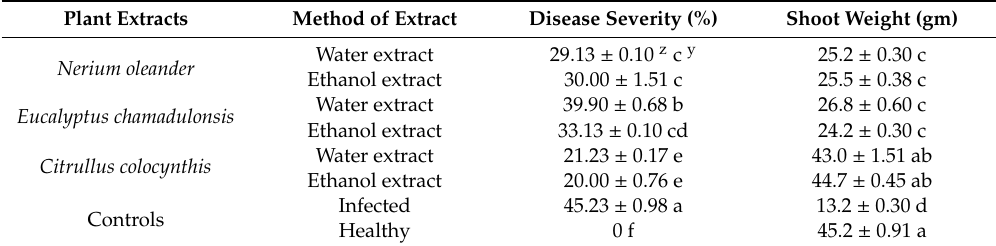
z Mean ± SE of 4 replicates (two seedlings each) for each treatment. y Values in the columns followed by the same letters are not significantly di ff erent according to Fisher’s protected least significant di ff erence at p ≤ 0.05